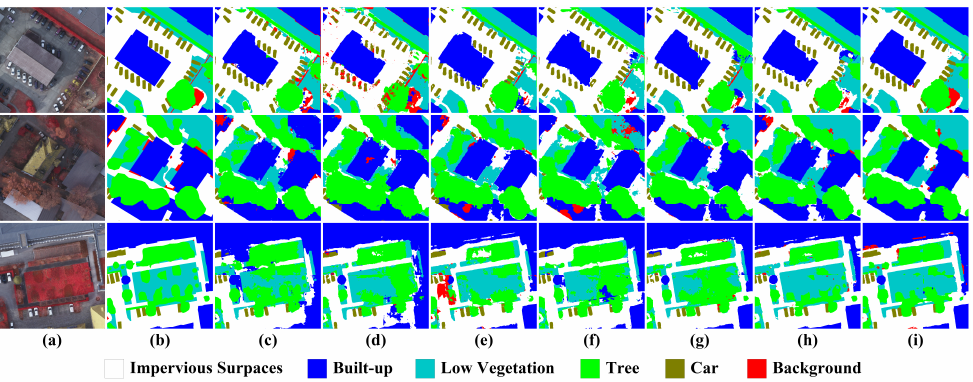
Figure 12. Comparison of segmentation results on the Postdam dataset: ( a ) Image; ( b ) Ground truth; ( c ) Baseline; ( d ) Baseline+SE; ( e ) Baseline+NLN; ( f ) Baseline+CBAM; ( g ) Baseline+DANet; ( h ) Baseline+ARM; and ( i ) XANet. Table 5. Accuracy comparison of different attention modules on the Postdam dataset. IS Building LV Tree Car